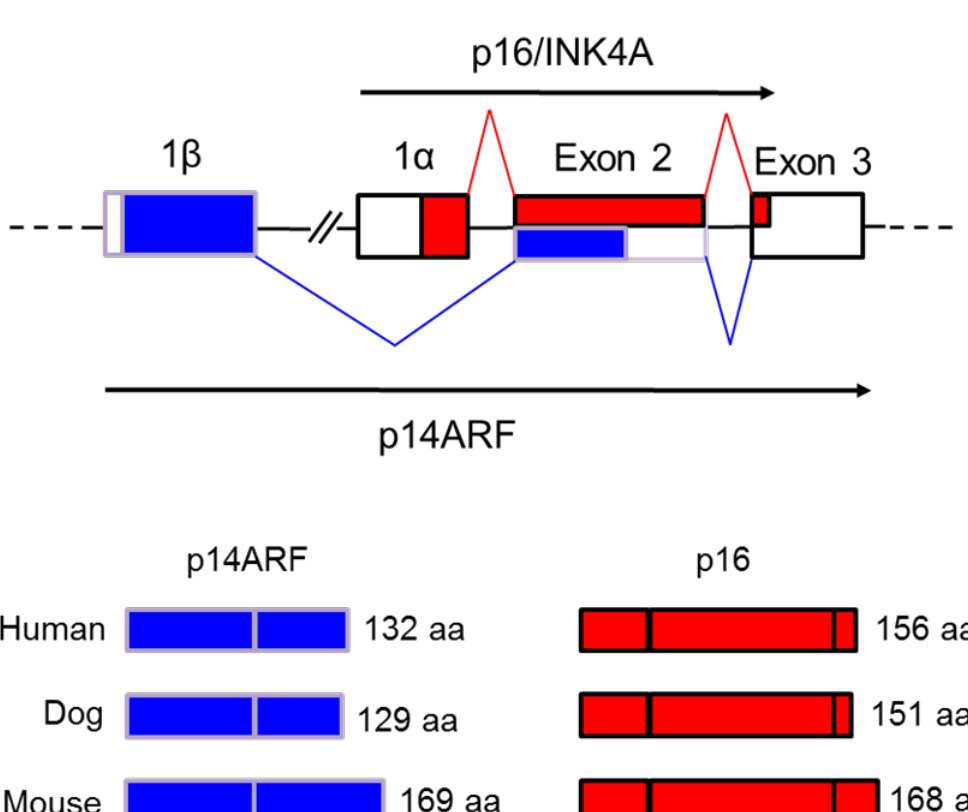
Figure 3. Alternative splicing results in two different transcripts and protein products from the modern INK4A/ARF locus. The exons are shown as boxes and the sequences encoding p16/INK4A are shown as red shading while those encoding the ARF transcript are colored blue. Exon 1 α is spliced to INK4A exon 2 and 3 forming the p16 mature transcript whereas exon 1 β is alternatively spliced to the same exon 2 and 3 generating the mature p14ARF transcript. The latter produces a different protein from p16 because translation occurs from an alternative reading frame. The sizes of the respective human, dog and mouse p16 and ARF proteins are shown in the bottom panel. (p14ARF in mouse is named p19ARF due to its increased length but should not be compared to p19/INK4D). On the other hand, p14ARF is highly unlikely to act as a direct inhibitor of CDK4/6 because of its structural differences from other INK4 proteins. A great number of studies, using mouse models and human cancer cells, differentiated the functions and regulation of p14ARF from that of p19ARF (the p14ARF ortholog in mouse) in embryonic fibroblasts or NIH 3T3 cells induced